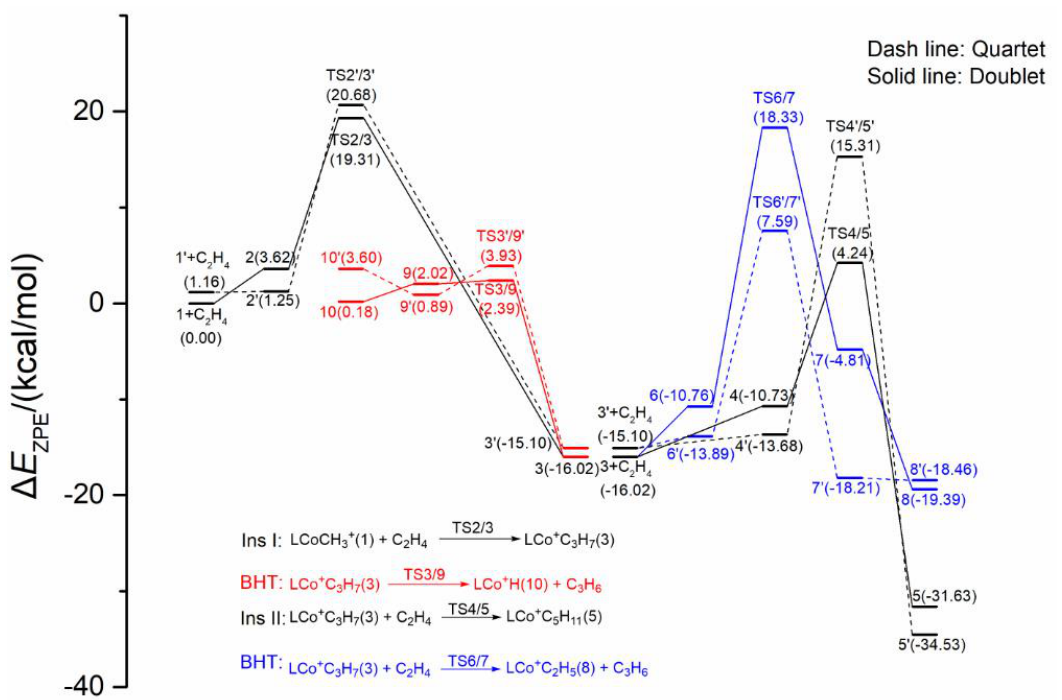
Figure 4. Energy profiles (kcal / mol) for the first and second ethylene coordination and insertion (black), β -H transfer ( BHT , in blue) and β -H elimination ( BHE , in red) catalyzed by the cationic cobalt complex in quartet (dash line) and doublet (solid line) spin states. The energies are relative zero-point energies with respect to the reactants: LCo + CH 3 ( 1 ) (doublet state) and C 2 H 4 . The number n corresponds to Co( + )- n , the TS m / n refers to the transition state between the two intermediates Co( + )- m and Co( + )- n .